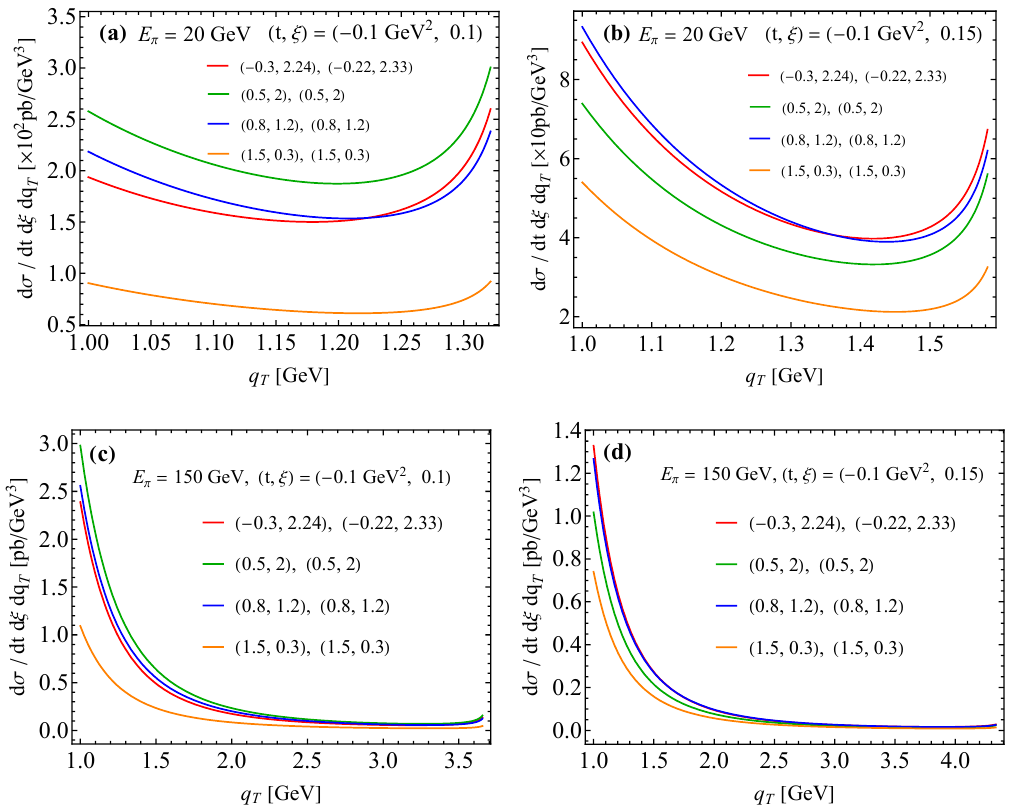
Figure 23. Differential cross section in eq. (3.34) as a function of photon q T for two choices of pion beam energies, along with two sets of ( t, ξ ) values. Different curves correspond to different ( ρ, τ ) parameters for the GPD models of the chiral-even GPDs followed by that of the chiral-odd GPDs. The rise at large q T is due to the Jacobian peak of the differential cross